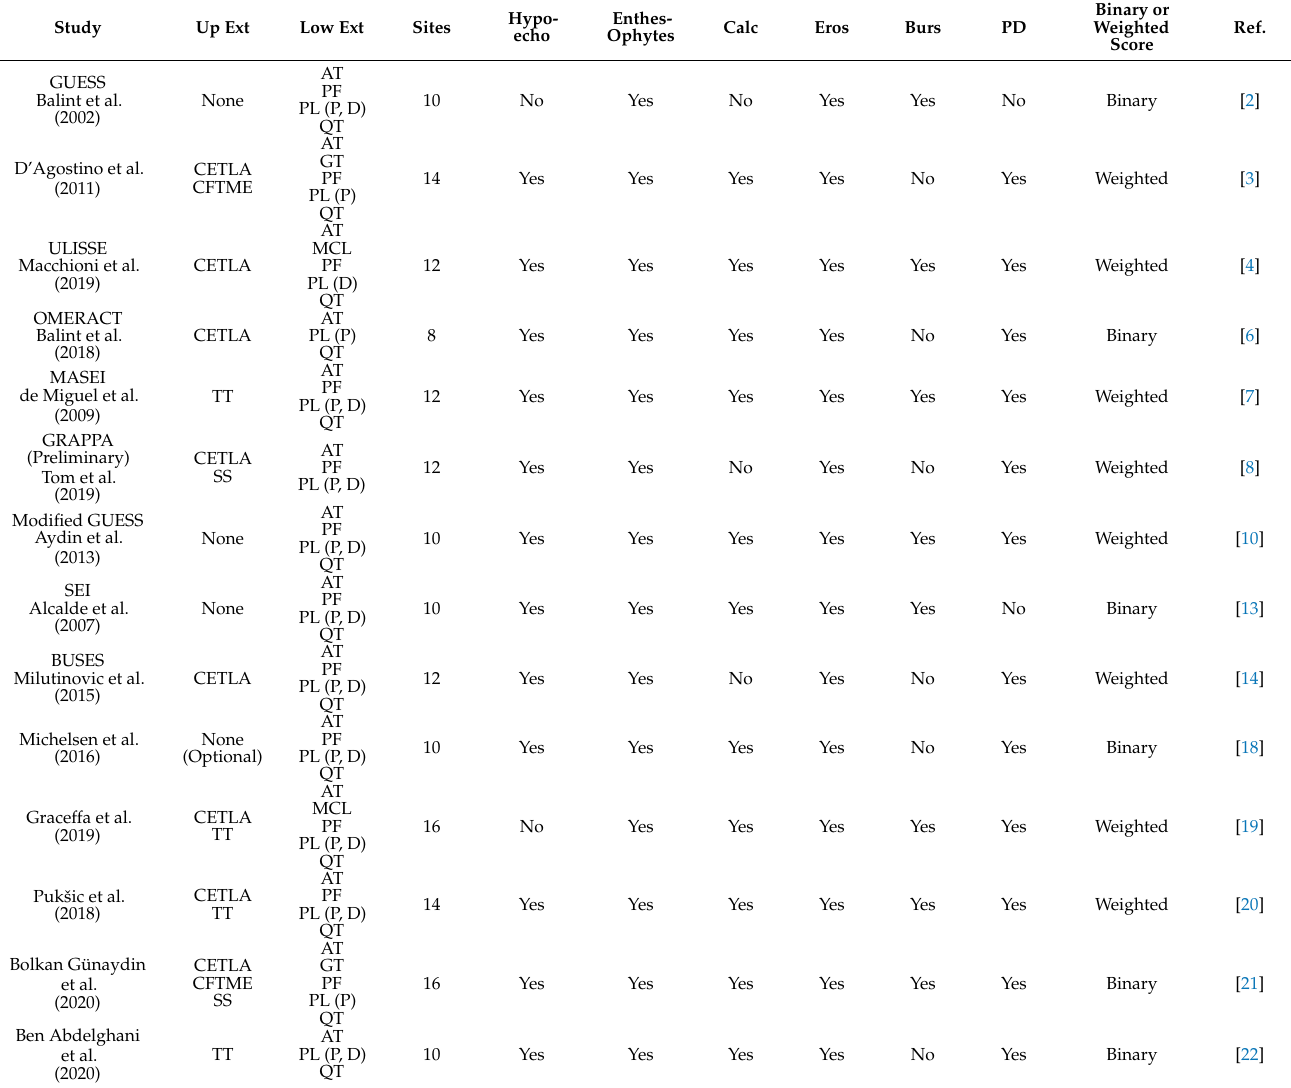
Table 1. Published Ultrasound Scores for